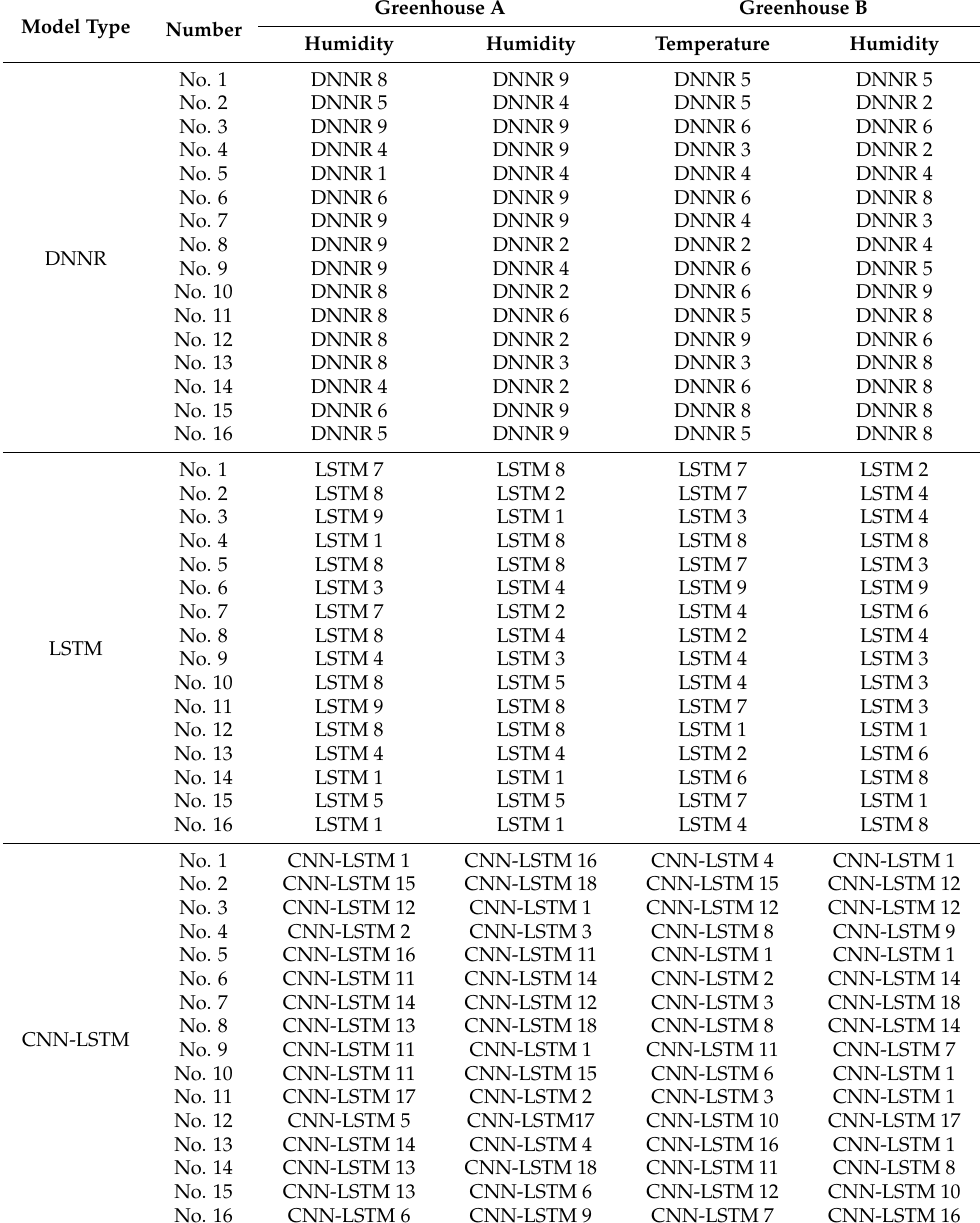
Table 7. The best performing models of each training set and corresponding test